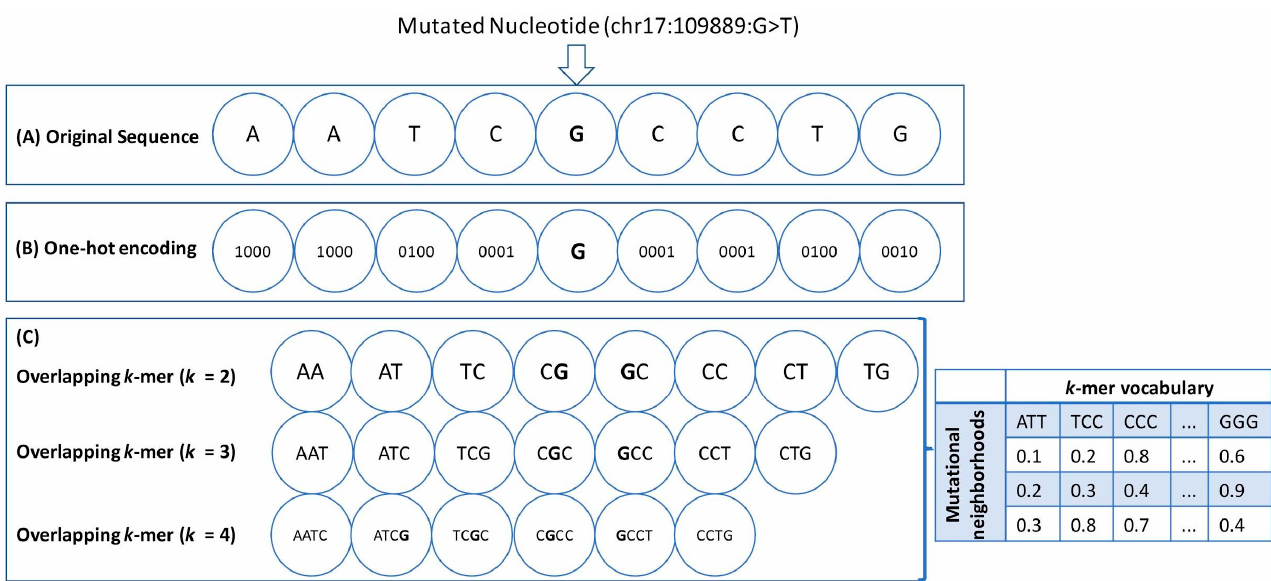
Figure 1. Neighborhood feature representations: A diagram representing the features derived from the neighborhood nucleotide sequences of the point mutations for an arbitrary window size of 4 is shown here. The mutated position is represented as a triplet (chromosome: position: substitution type). ( A ) The original sequence is represented here with the mutated nucleotide (ch17:109889:G > T) in bold. ( B ) One-hot encoding was used to derive the 4-bit binary one-hot encoded vector for each nucleotide. ( C ) Overlapping k -mers of sizes 2, 3, and 4 have been represented here. In this case, the neighborhood features also include the wild-type nucleotide at the mutated position. The overlapping k -mers were encoded into a numerical format using the Count Vectorizer and the TF-IDF Vectorizer, and the resulting word matrix was derived. The samples (or individual neighborhoods) are represented as rows, and the k -mers are represented as columns. The chromosome number and the substitution type (A > T, G > C, etc.) were included as additional features for both types of feature representation.